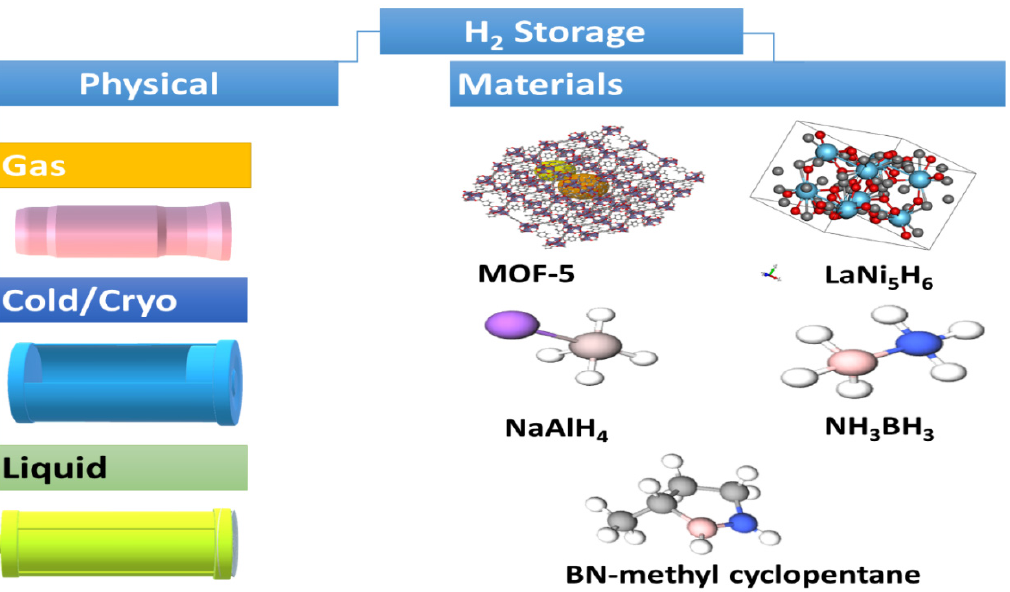
Figure 2. The main H 2 storage methods.